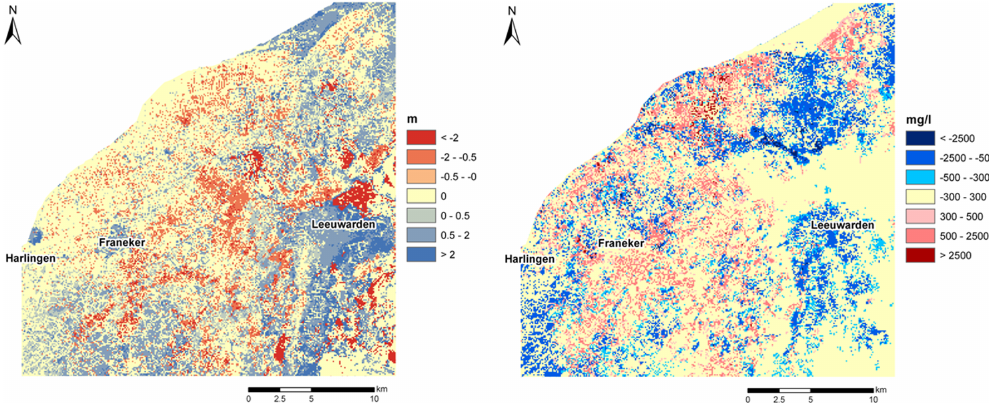
under the first confining layer between the autonomic scenario (year 2100) and the present Fig. 19. Left panel: change in the thickness of the fresh water lenses in the summer autonomic scenario (year 2100) and present case (year case (year 2005). Red colours show salinisation and blue colours freshening of the 2005). Red indicates that the thickness of the fresh water lenses decreases, and blue indicates that it increases. Right panel: change in